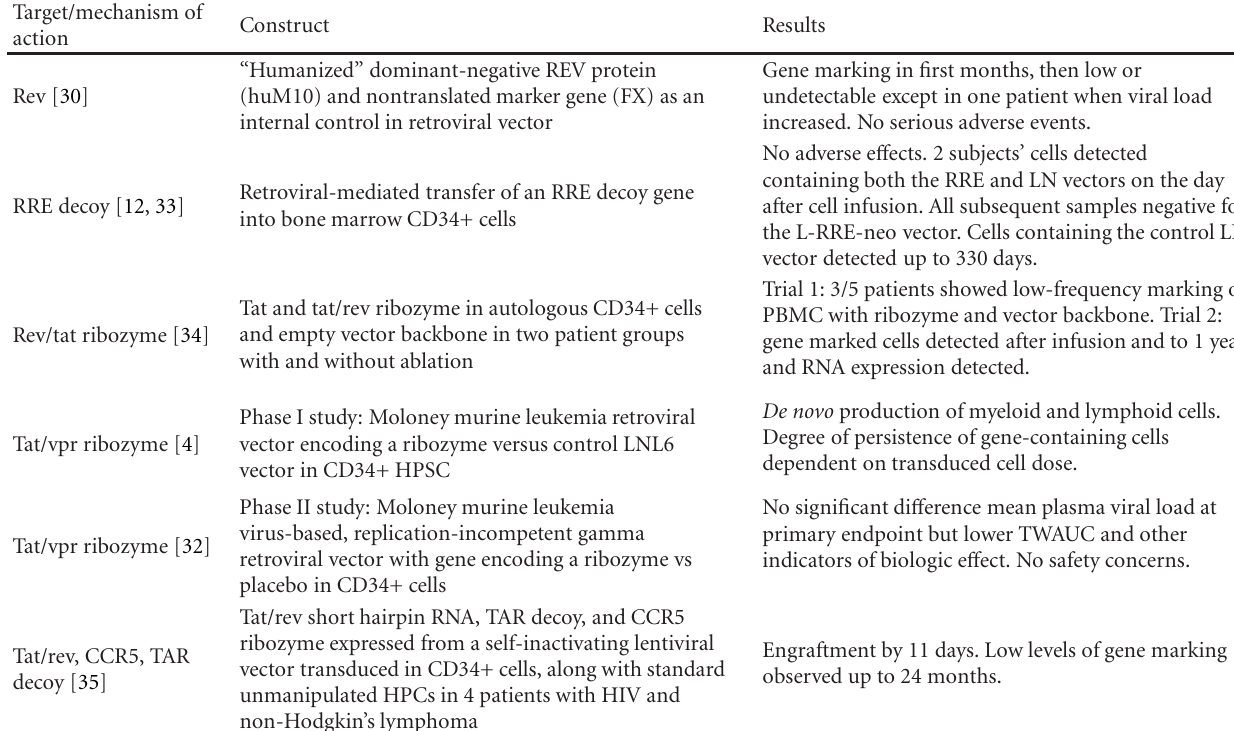
Target/mechanism